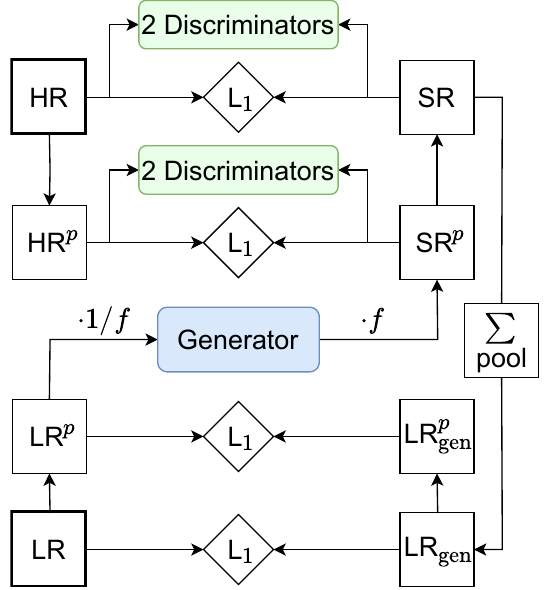
Figure 3: Training process for jet images. The generator and discriminator networks are shown in Fig.